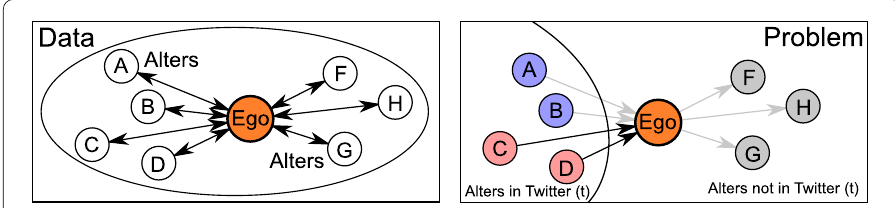
Figure 2 Twitter data and the shadow profiles problem. The left panel shows a schema of the data used in this study. We count with a set of ego users who are connected to their alters through links based on their Twitter replies. The right panel shows the shadow profile problem. For each ego user, we count with preceding alters that had already joined Twitter at the time when the ego joined. Out of those preceding alters, some disclosed their contact lists in Twitter (red) and others did not (blue). The shadow profile problem consists of the inference of personal information of the ego user based only on the information given by disclosing preceding alters, ignoring all data from non-disclosing preceding alters and alters that joined Twitter after the ego